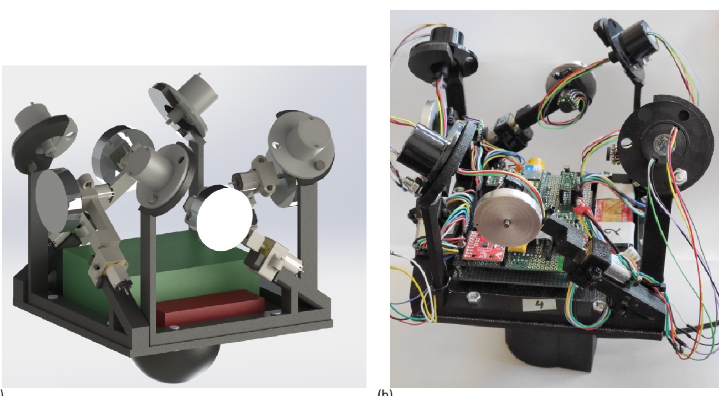
Figure 1. ACS on hemispherical 3D-printed platform. ( a ) CAD model and ( b ) actual CMG-Air bearing